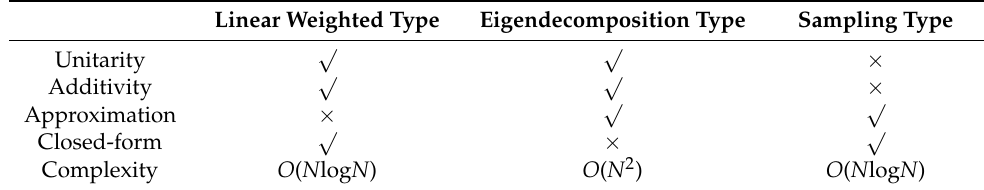
Table 2. Comparison of the three main types of DFRFT.